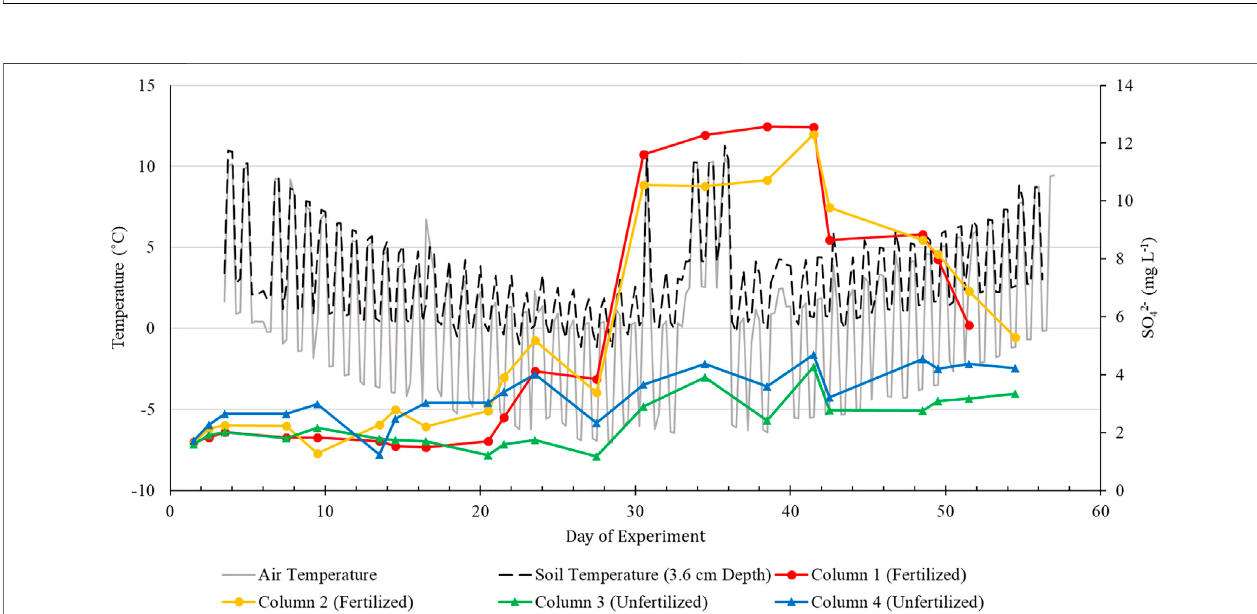
FIGURE 4 | Temperature and leachate SO 42- concentrations versus time for fertilized and unfertilized columns.